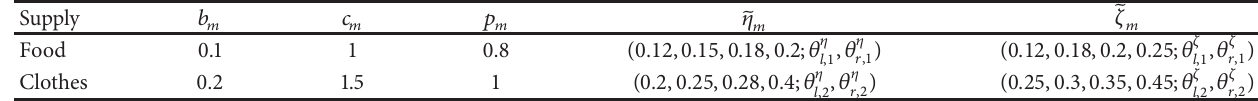
Table 3: Parameters related to different emergency supplies.